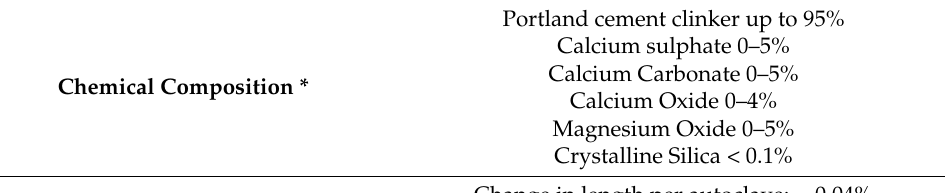
Table 1. Chemical composition and physical properties of the cement adopted.